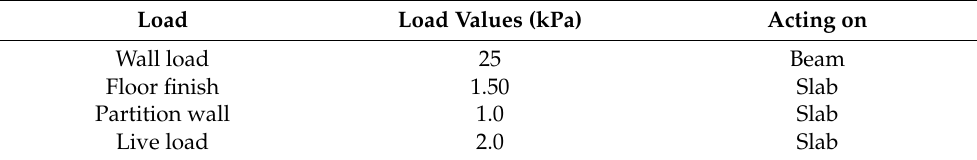
Table 4. Applied loads [37].